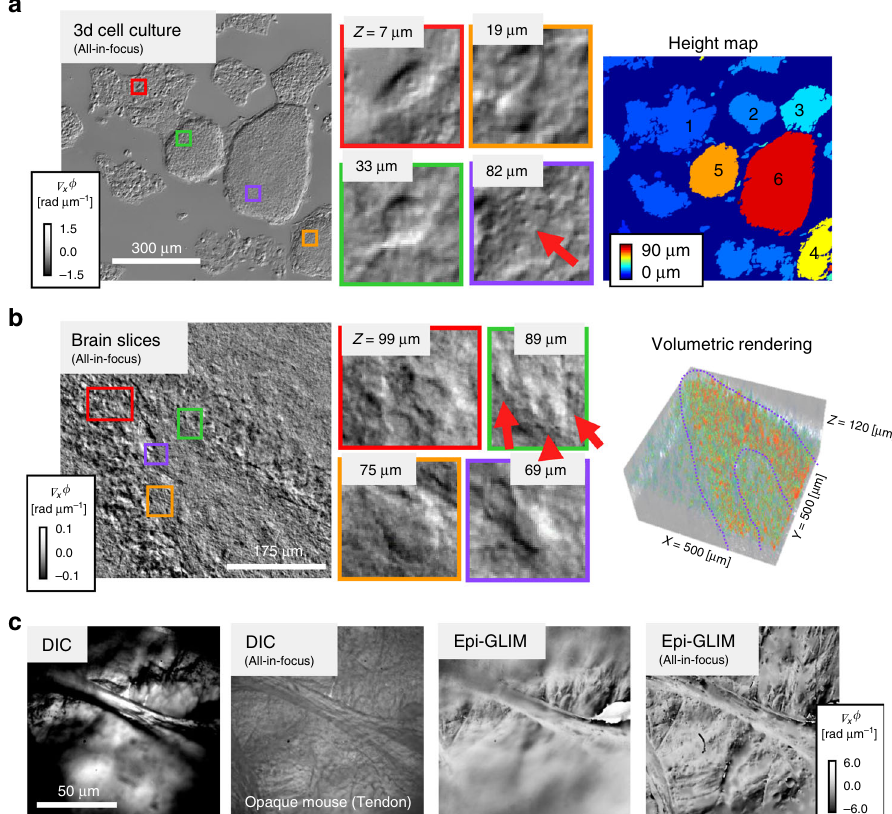
Fig. 5 Epi-GLIM for turbid and opaque structures. a GLIM reveals cellular level details in a multilayer cell culture (×10/0.3, HepG2 liver cancer spheroids, red arrow nucleoli inside a single cell). By fi nding the axial section that maximizes the focus, it is possible to recover a height map giving the approximate volume of the spheroids. b All-in-focus projection of an acute brain slice imaged in re fl ection (×20/0.5, ~1.5 μ m axial resolution, see Supplementary Fig. 3 for a comparison with theory). As the epi-GLIM reconstruction process suppresses out of focus illumination, small changes to the focus will reveal distinct cellular layers (red arrows pointing to pyramidal neurons). The volumetric rendering highlights the comparably denser crescent of pyramid cells (purple outline). Individual z slices show cellular level detail. c Exposed mouse tendon, imaged under a long working distance objective (×100/0.75). Epi-GLIM improves the contrast compared to re fl ected light DIC at maximum extinction. The difference is accentuated in the all-in-focus image, where the contrast in re fl ected light DIC is dominated by amplitude contributions which appear as edges in the all-in-focus